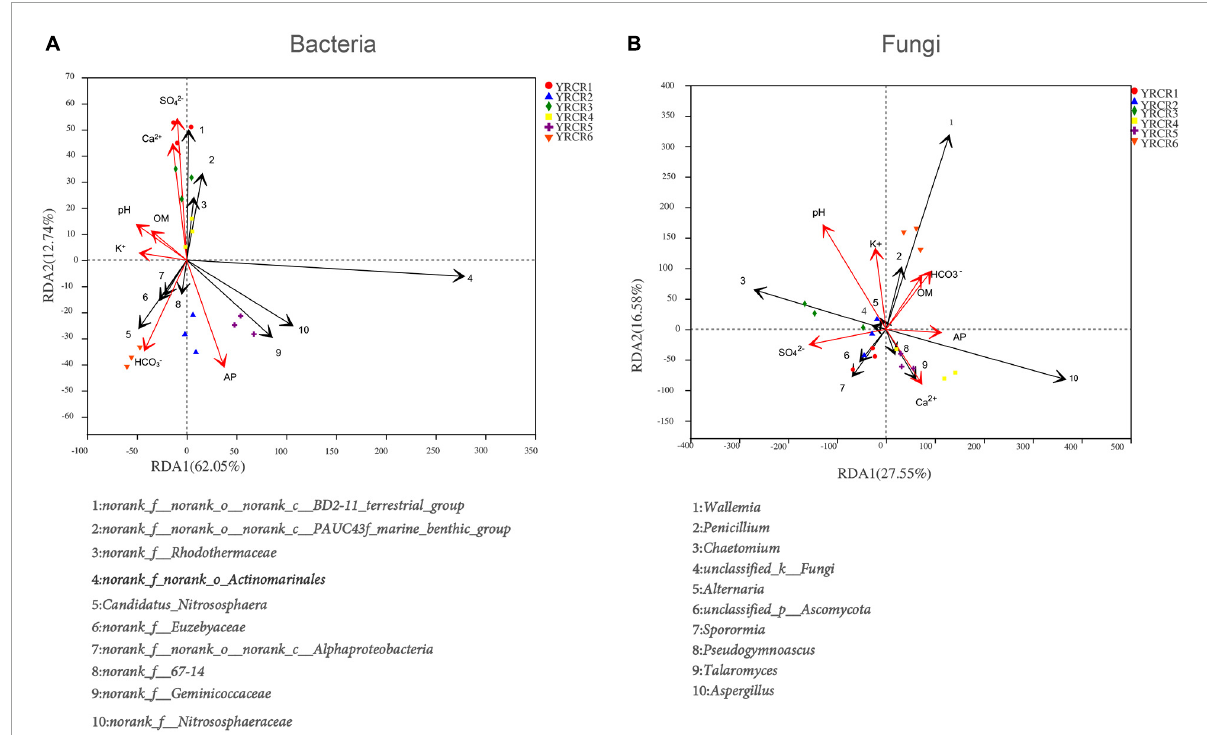
FIGURE6 (A) Is RDA of the correlation between bacterial and soil physicochemical on genus level. (B) Is RDA of the correlation between fungal and soil